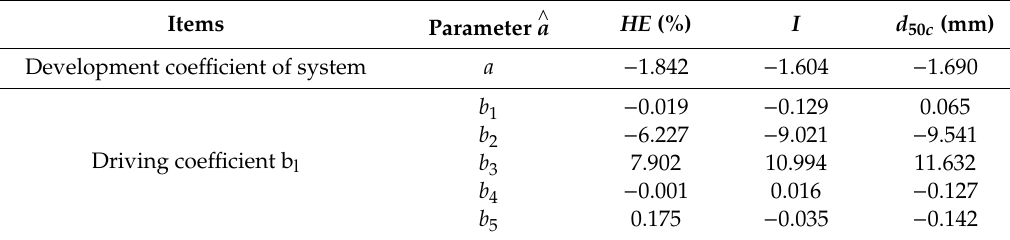
∧ a for the dimensionless performance evaluation in TPHS. Table 5. Parameter ∧ Items Parameter a HE (%) I d 50 c (mm) Development coe ffi cient of system a − 1.842 − 1.604 − 1.690 b 1 − 0.019 − 0.129 0.065 b 2 − 6.227 − 9.021 − 9.541 Driving coe ffi cient b l b 3 7.902 10.994 11.632 b